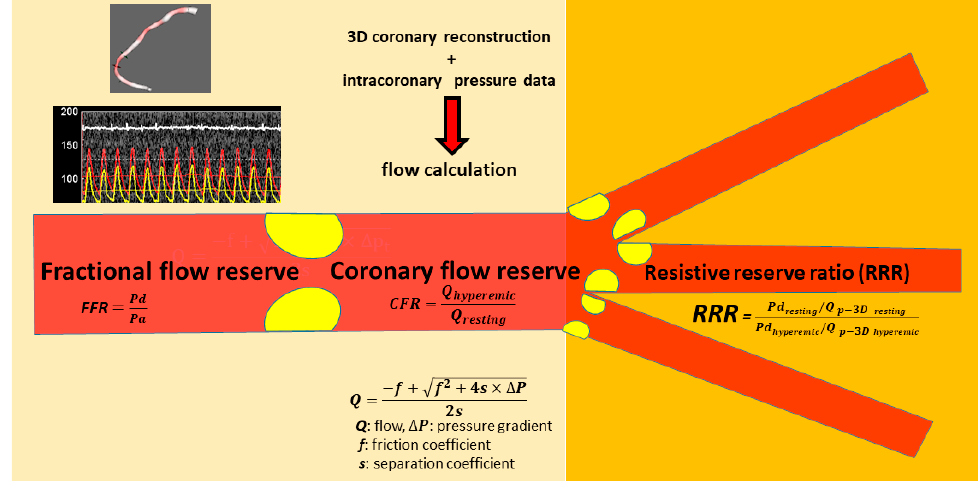
Figure 1. Calculation of CFR and RRR values during FFR measurement. The method for calculating CFR p-3D and RRR p-3D uses hemodynamic calculations combining intracoronary pressure data (top left panel) and 3D anatomical parameters (bottom left panel). Based on the hyperemic and resting pressure data, as well as 3D anatomical parameters, simple hemodynamic equations were used to calculate resting and hyperemic flow, CFR, and RRR. The detailed description of the flow calculations is described in the patent of the method: https://patents.google.com/patent/WO2019175612A2/en (accessed on 5 March 2022).